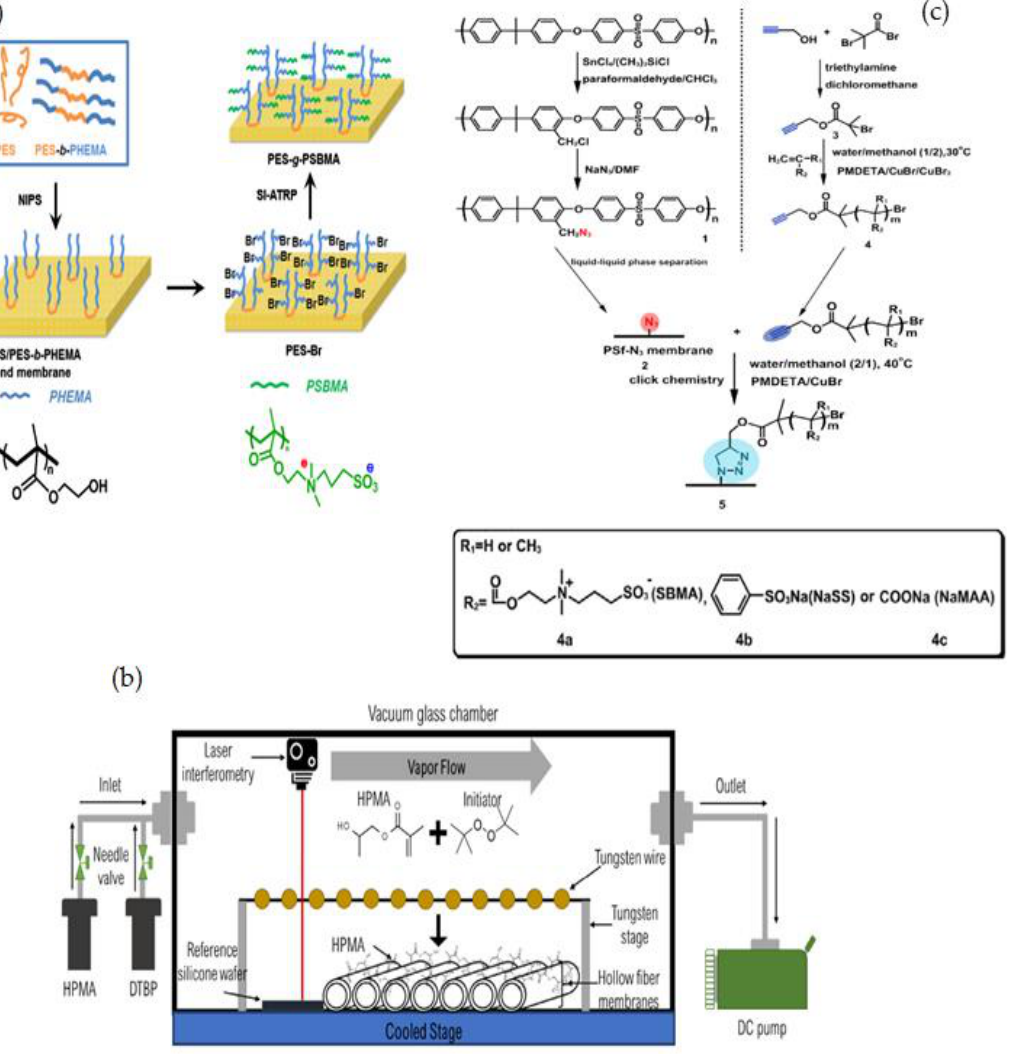
Figure 9. ( a ) Synthetic route of PES-g-PSBMA [152], ( b ) Schematically illustration of iCVD system [153], ( c ) Schematically preparation of PSF-N 3 , alkynyl-functionalized polymers, and modified PSF membrane by click chemistry [127].